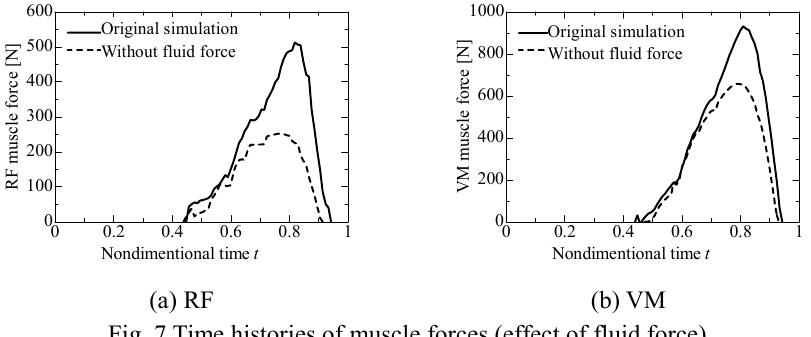
Fig. 7 Time histories of muscle forces (effect of fluid